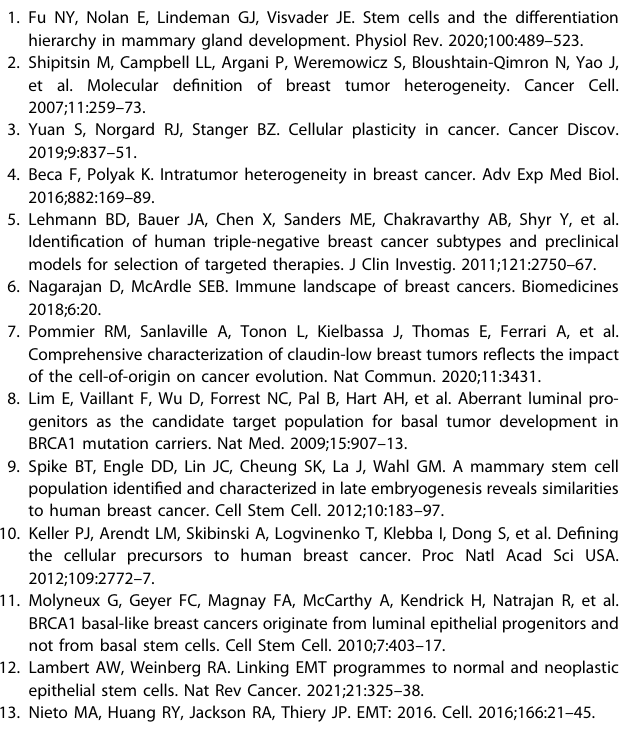
Fig. 7 FOXA1 associates with the differentiation plasticity of SNAI1 knockout cells via regulation of AR expression. A RT-qPCR analysis of ER , PGR , HER2 and AR in ZR-75-1, MCF-7, MDA-MB-231-WT and SNAI1 -KO cells. B Boxplots showing the expression of AR in various human BRCA subtypes in TCGA datasets (Basal n = 171, HER2 n = 78, Luminal A n = 499, Luminal B n = 197). The statistical signi fi cance is derived using the Wilcoxon rank-sum test ( U test). C Scatter plot demonstrating the negative correlation between SNAI1 and AR expression in BRCA samples obtained from TCGA datasets. D Representative phase contrast images from three biological repeats showing the morphology of MDA-MB- 231-WT, SNAI1 -KOs and ZR-75-1 cells at day 5 of treatment with 0.05 μ M of the androgen antagonist enzalutamide. Scale bars = 100 μ M. E Representative phase contrast images from three biological repeats showing the morphology of mammospheres derived from MDA-MB- 231-WT, SNAI1 -KOs and ZR-75-1 cells at day 5 of treatment with either DMSO or 0.05 μ M enzalutamide. Scale bars = 200 μ M. F Quanti fi cation of the cross-section area of the mammospheres. G Scatter plot demonstrating the positive correlation between FOXA1 and AR expression in BRCA samples obtained from TCGA datasets. H RT-qPCR analysis of FOXA1 and AR expression in CS16 SNAI1 -KO after knocking down